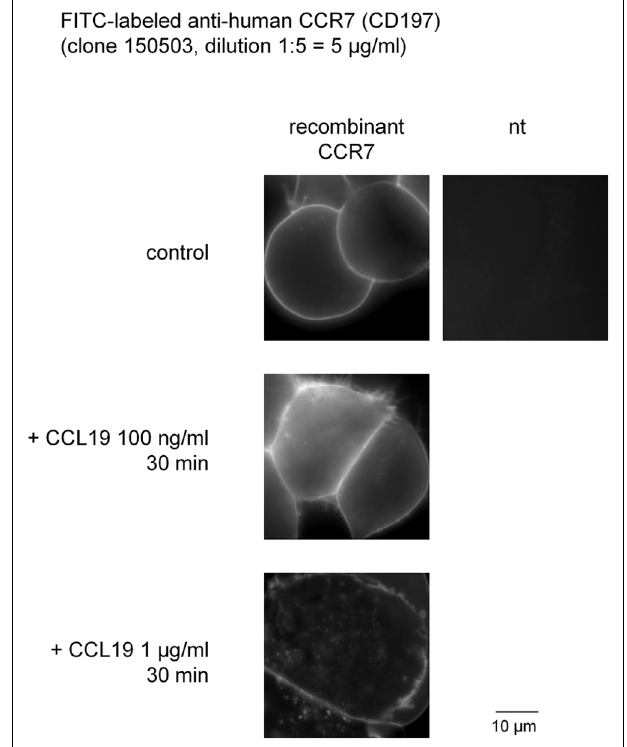
FIGURE 1 | Internalization of fluorescein isothiocyanate-conjugated monoclonal anti-human CCR7 induced by recombinant CCL19 in intact HEK 293a cells that express recombinant CCR7. nt, non-transfected cells.